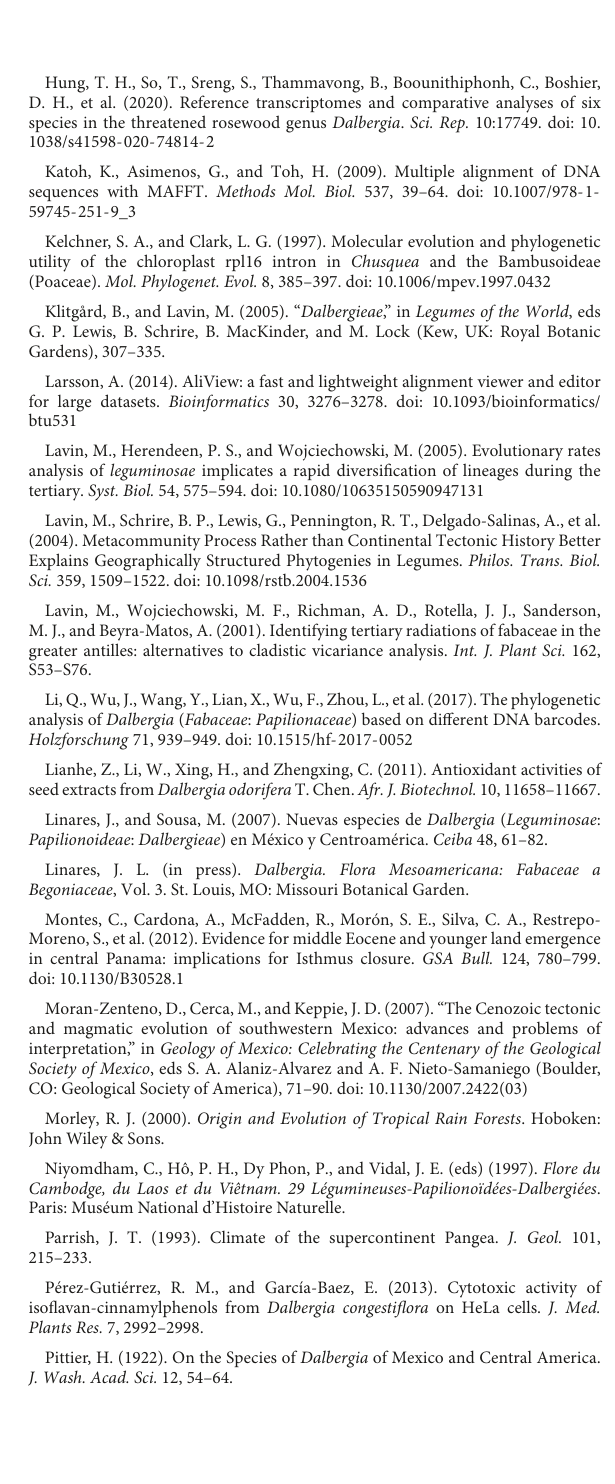
SUPPLEMENTARYFIGURE6 Haplotype network for plastid markers of Dalbergia . SUPPLEMENTARYTABLE1 List of Dalbergia species and allies used in this